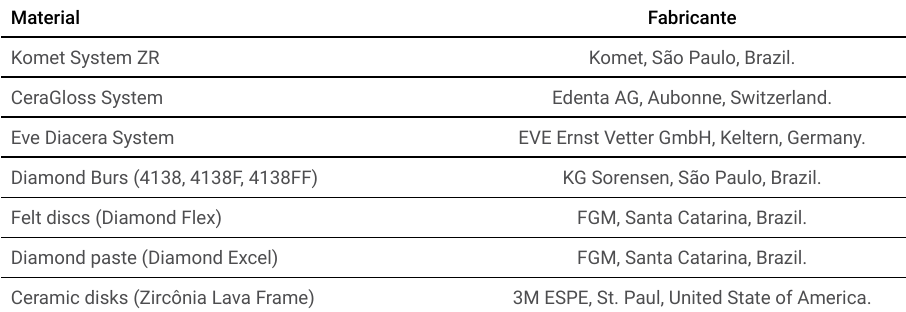
Table 1. Materials used in this study.